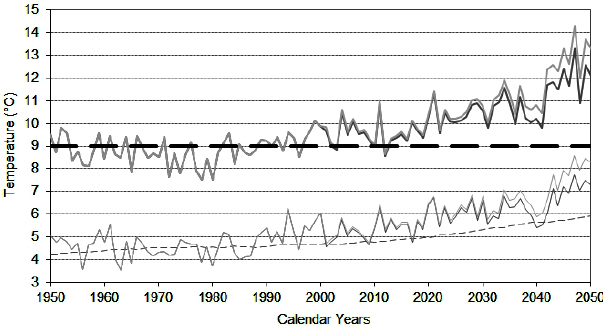
Fig. 1 . Grassland-forest mosaic in year 2000 of the simulated pastures, as estimated by aerial photograph interpretation by M. Kalbermatten (see Chételat et al. this issue): the almost treeless intensively grazed pasture Les Planets Ouest (IWP), the moderately grazed pasture Planets Milieu Est (MWP), and the extensively grazed true mosaic pasture Les Cluds Sud (EWP).